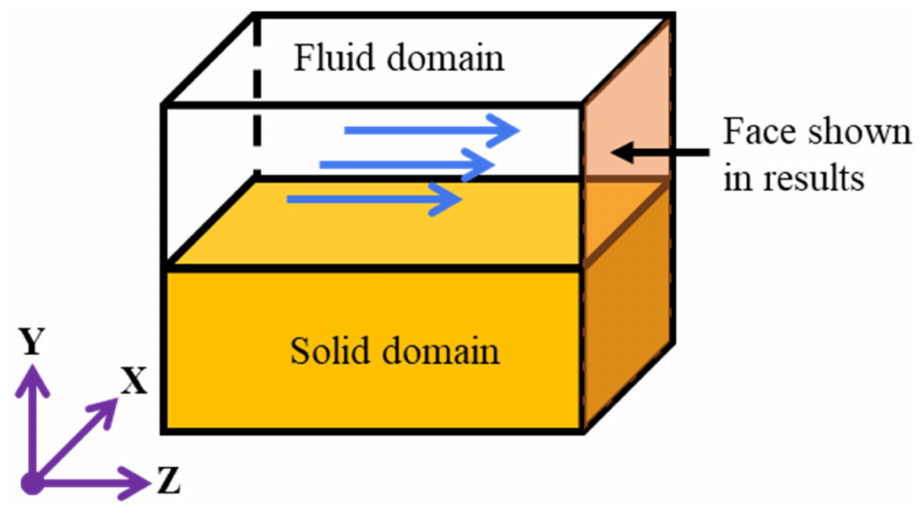
Figure 16. Numerical calculation model of ablation.